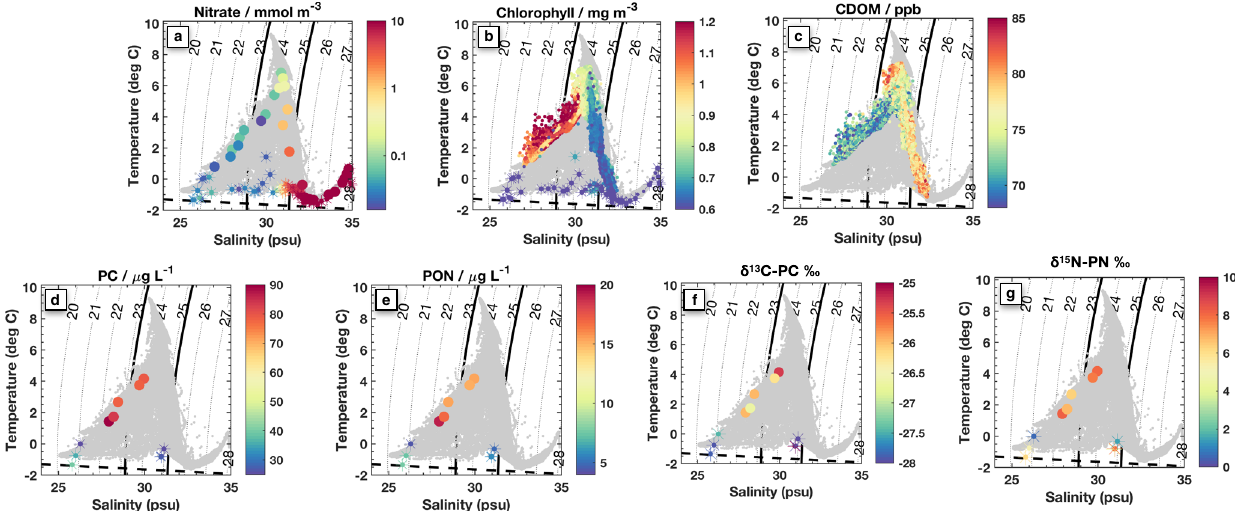
Fig. 7 Biogeochemical signatures of Paci fi c Summer Water (PSW): temperature – salinity (T-S) patterns. T-S panels in the same style as Fig. 3 are colored by a Nitrate concentration, b Chlorophyll, c CDOM, d particulate carbon (PC) concentration, e particulate organic nitrogen (PON) concentration, f particulate carbon isotopes, g particulate organic nitrogen isotopes. In b , c small dots are from the Wirewalker measurements, and in all panels larger symbols are from ship-board CTD bottle samples taken from casts that were conducted at locations where the warm jet was ( fi lled circles) and was not (stars)